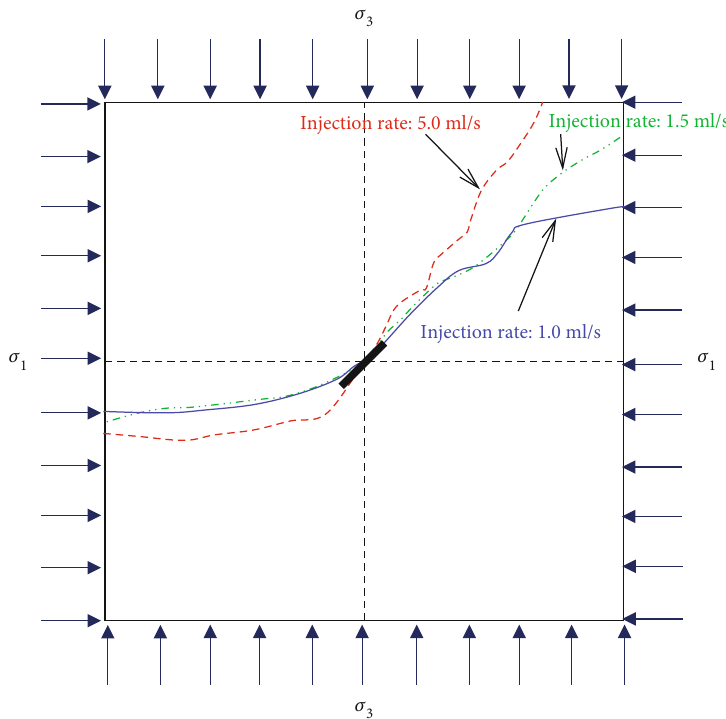
Figure 11: The comparison of the HF de fl ecting propagation trajectories at di ff erent loading